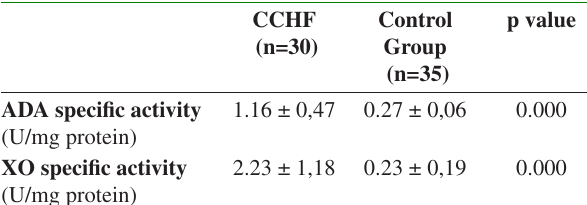
Table 2 - Serum ADA and XO levels in CCHF patients and